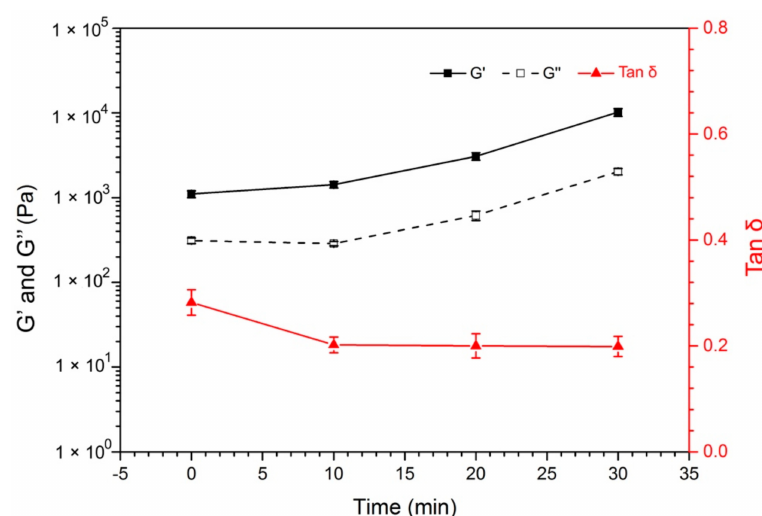
Figure 5. The e ff ect of 365 nm light irradiation time on Azo-alginate gel mechanical